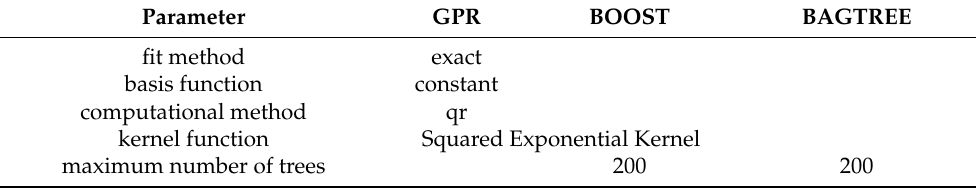
Table A2. Standard configuration of MLRAs using the ARTMO